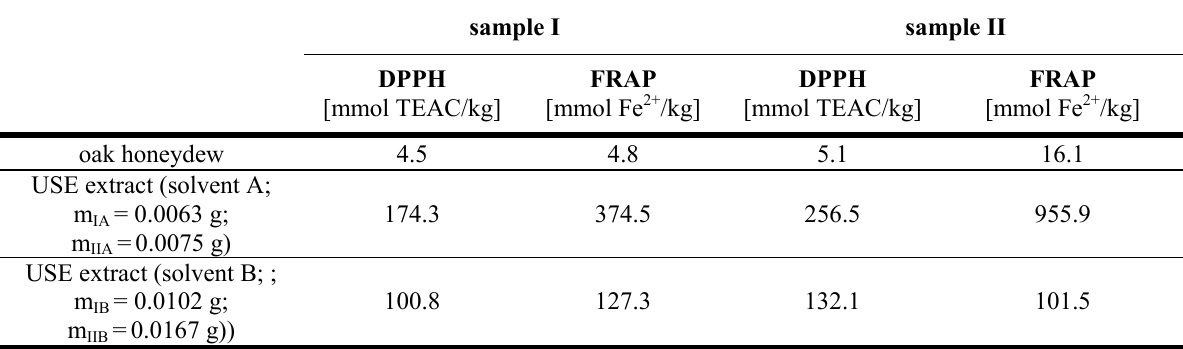
Table 3. Results of DPPH and FRAP quantitative assay for the honeydew (as mmol TEAC/kg honeydew and mmol Fe 2 /kg honeydew) and the extracts (as mmol TEAC/kg extract or mmol Fe 2 /kg extract). Solvent A and solvent B are described in Table 2. sample I sample II